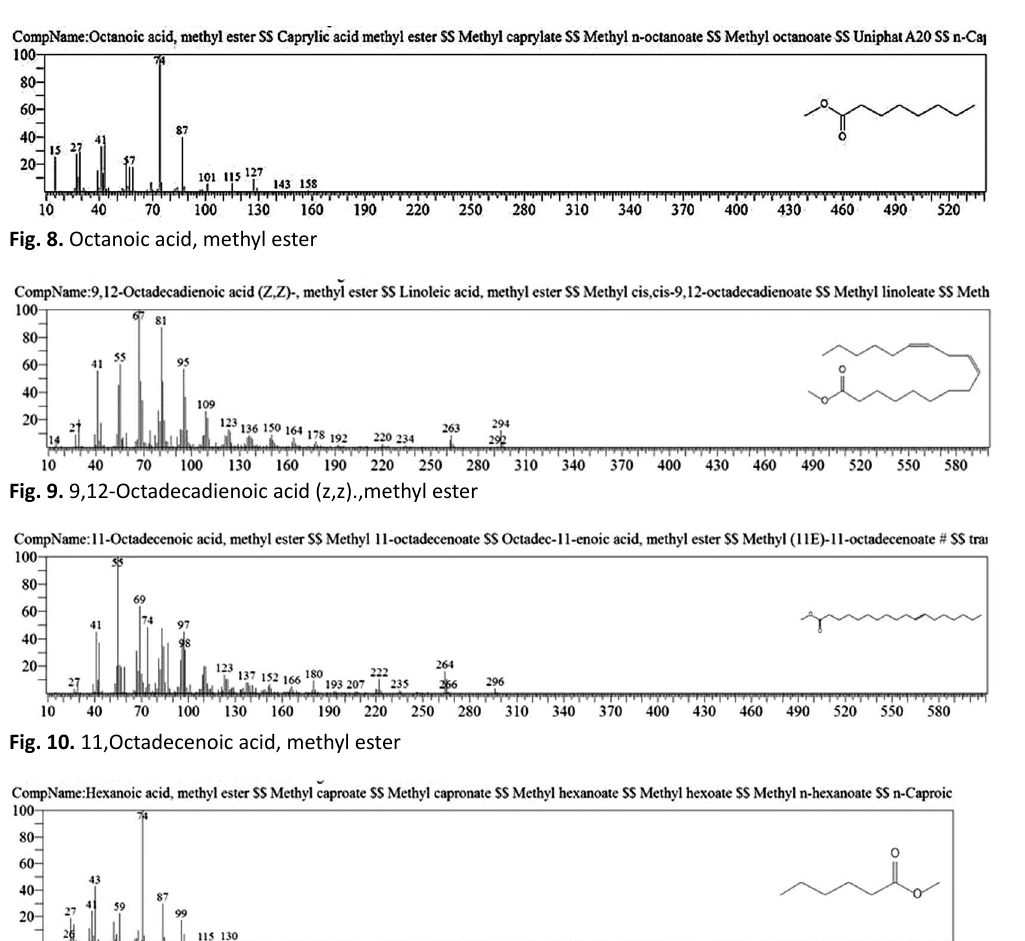
Fig. 11. Hexanoic acid, methyl ester